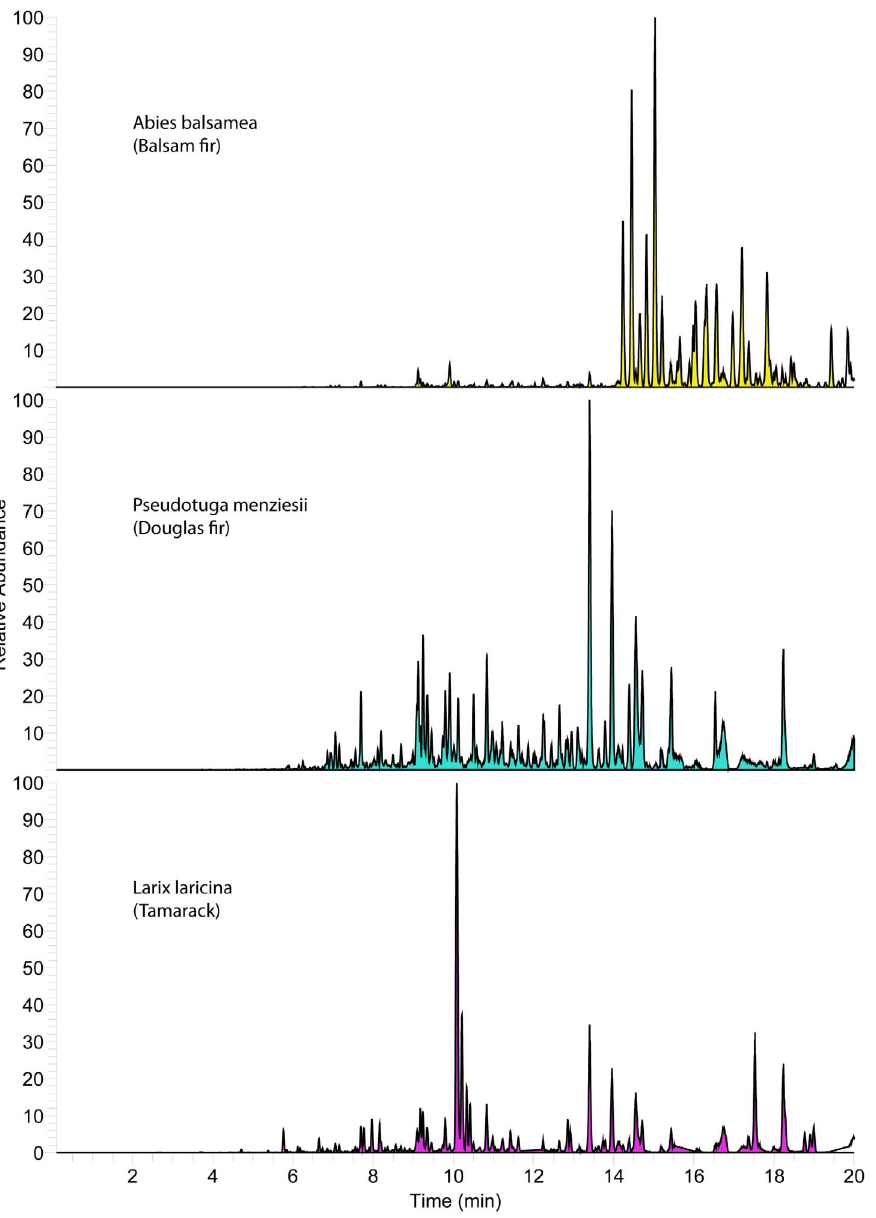
Figure 5. Resin metabolite diversity of other studied conifers. Base-peak negative-ion chromatogram (‘‘fingerprints’’) of resin collected from other conifers within 2 miles of the study apiary.